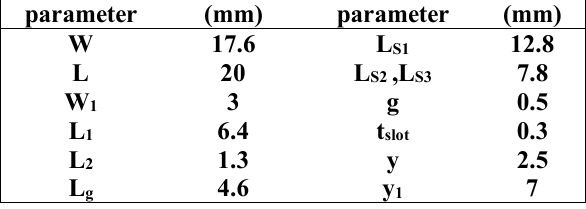
Table 1: Dimensions of proposed antenna (mm).